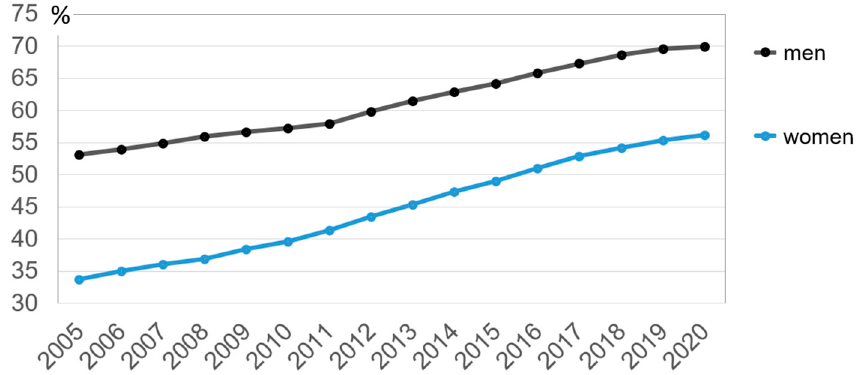
Figure 1. Share of employed persons in the age group 55-64 in the EU-27 (Source: [30]).